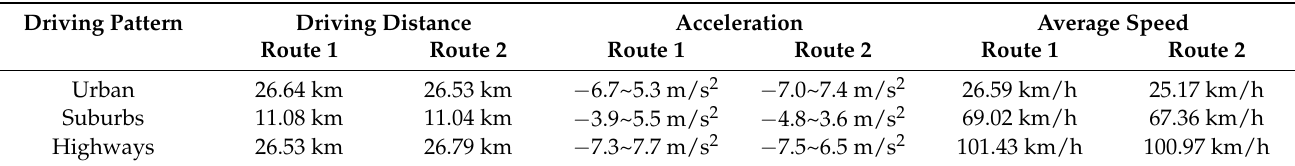
Table 3. Driving pattern of the testing vehicle on real